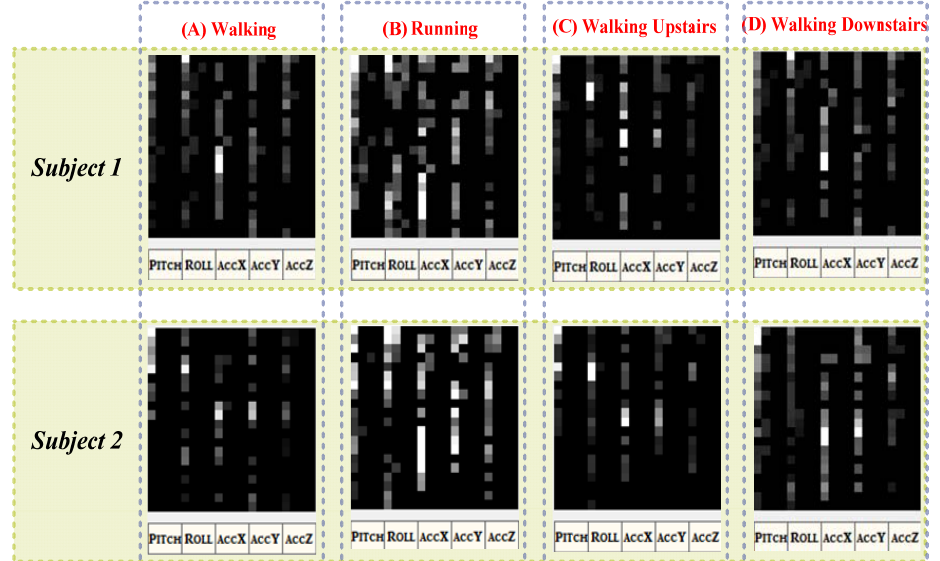
Figure 15. The spectral energy diagrams of walking, running, walking upstairs and walking downstairs from subject 1 and subject